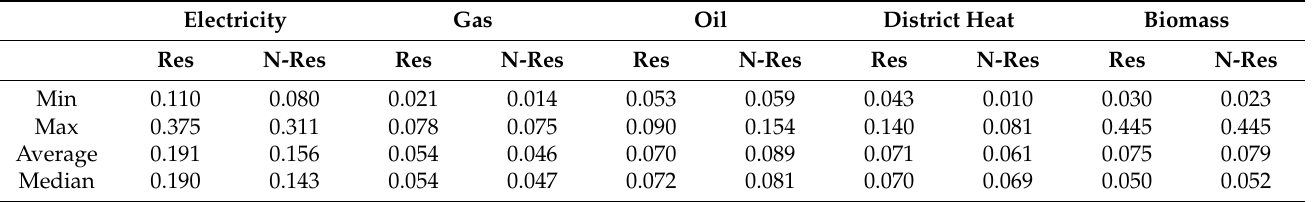
Figure 6. Annual increase in energy prices used by Member States for non-residential sector. Table 2. Statistics about the energy prices selected for residential (Res) and non-residential The figures demonstrate that the divergences are not as relevant for energy prices. (N-Res) buildings. Only a few cases (e.g., Flanders, Belgium for electricity and Wallonia, Belgium for bio- mass) referred to values not close to the averages.